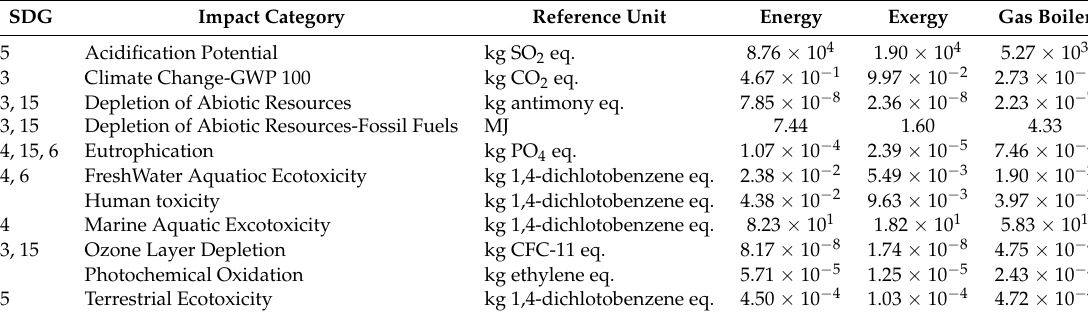
Figure 5. Summary of impacts as a percentage of the total. Table 8. The overall impact for the different categories and for the different allocation